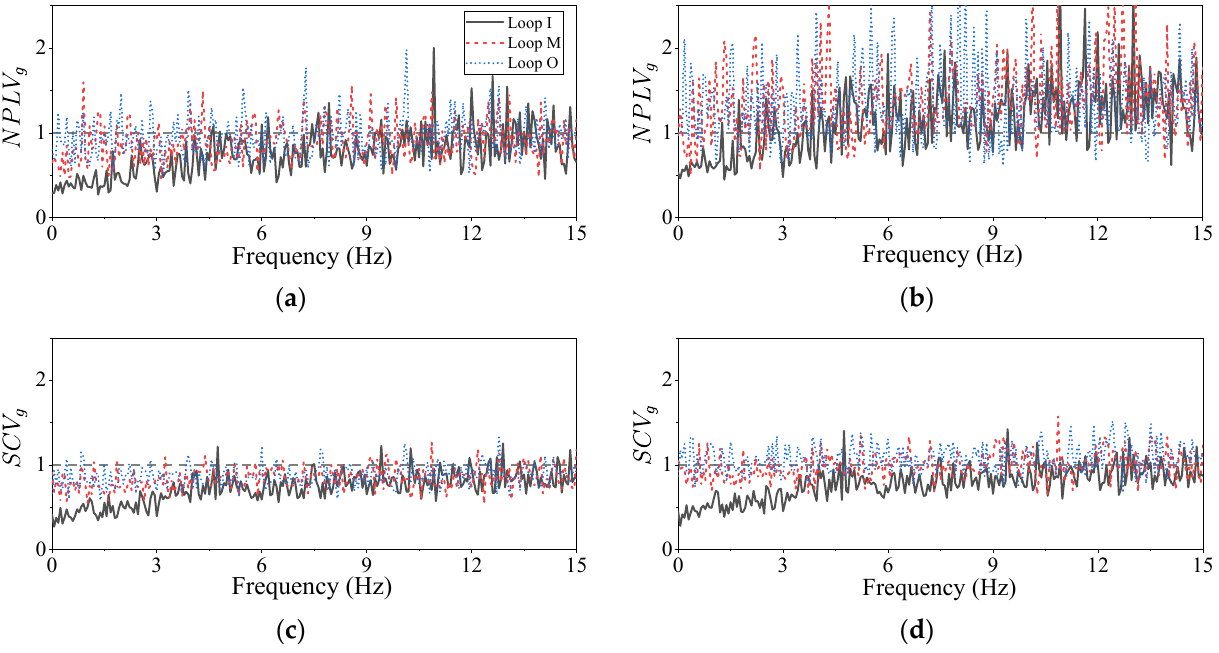
Figure 10. Numerical realization of the normalized periodograms’ variance and SCV: ( a ) variance of Gaussian model, ( b ) variance of modified Gaussian model, ( c ) SCV of Gaussian model, and ( d ) SCV of modified Gaussian model.